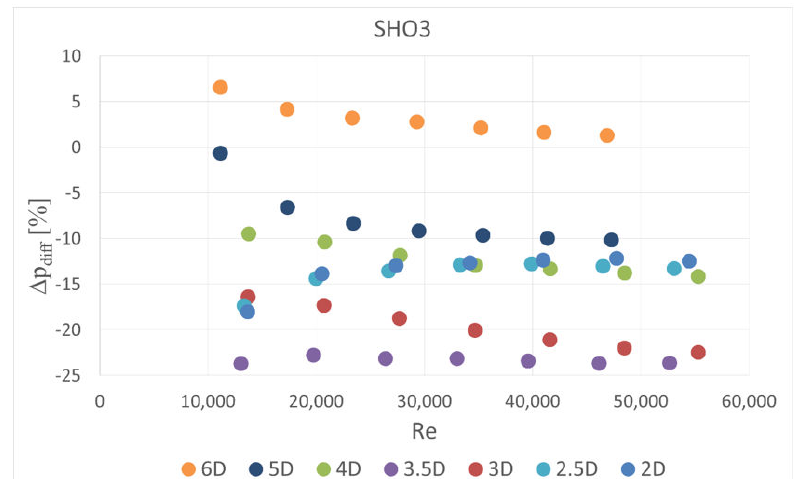
Figure 13. Pressure drop di ff erence for SHO3.